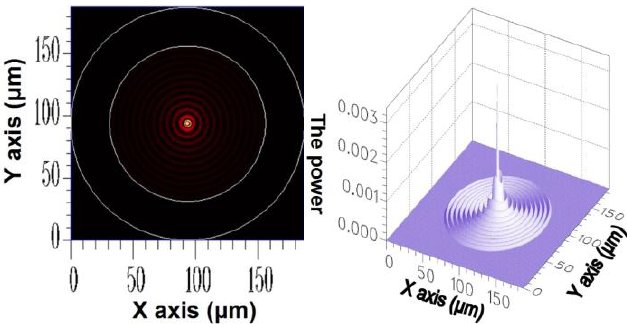
Figure 6. The 2D and 3D power diagram of the cladding mode ( ν = 21) with an effective refractive index of .